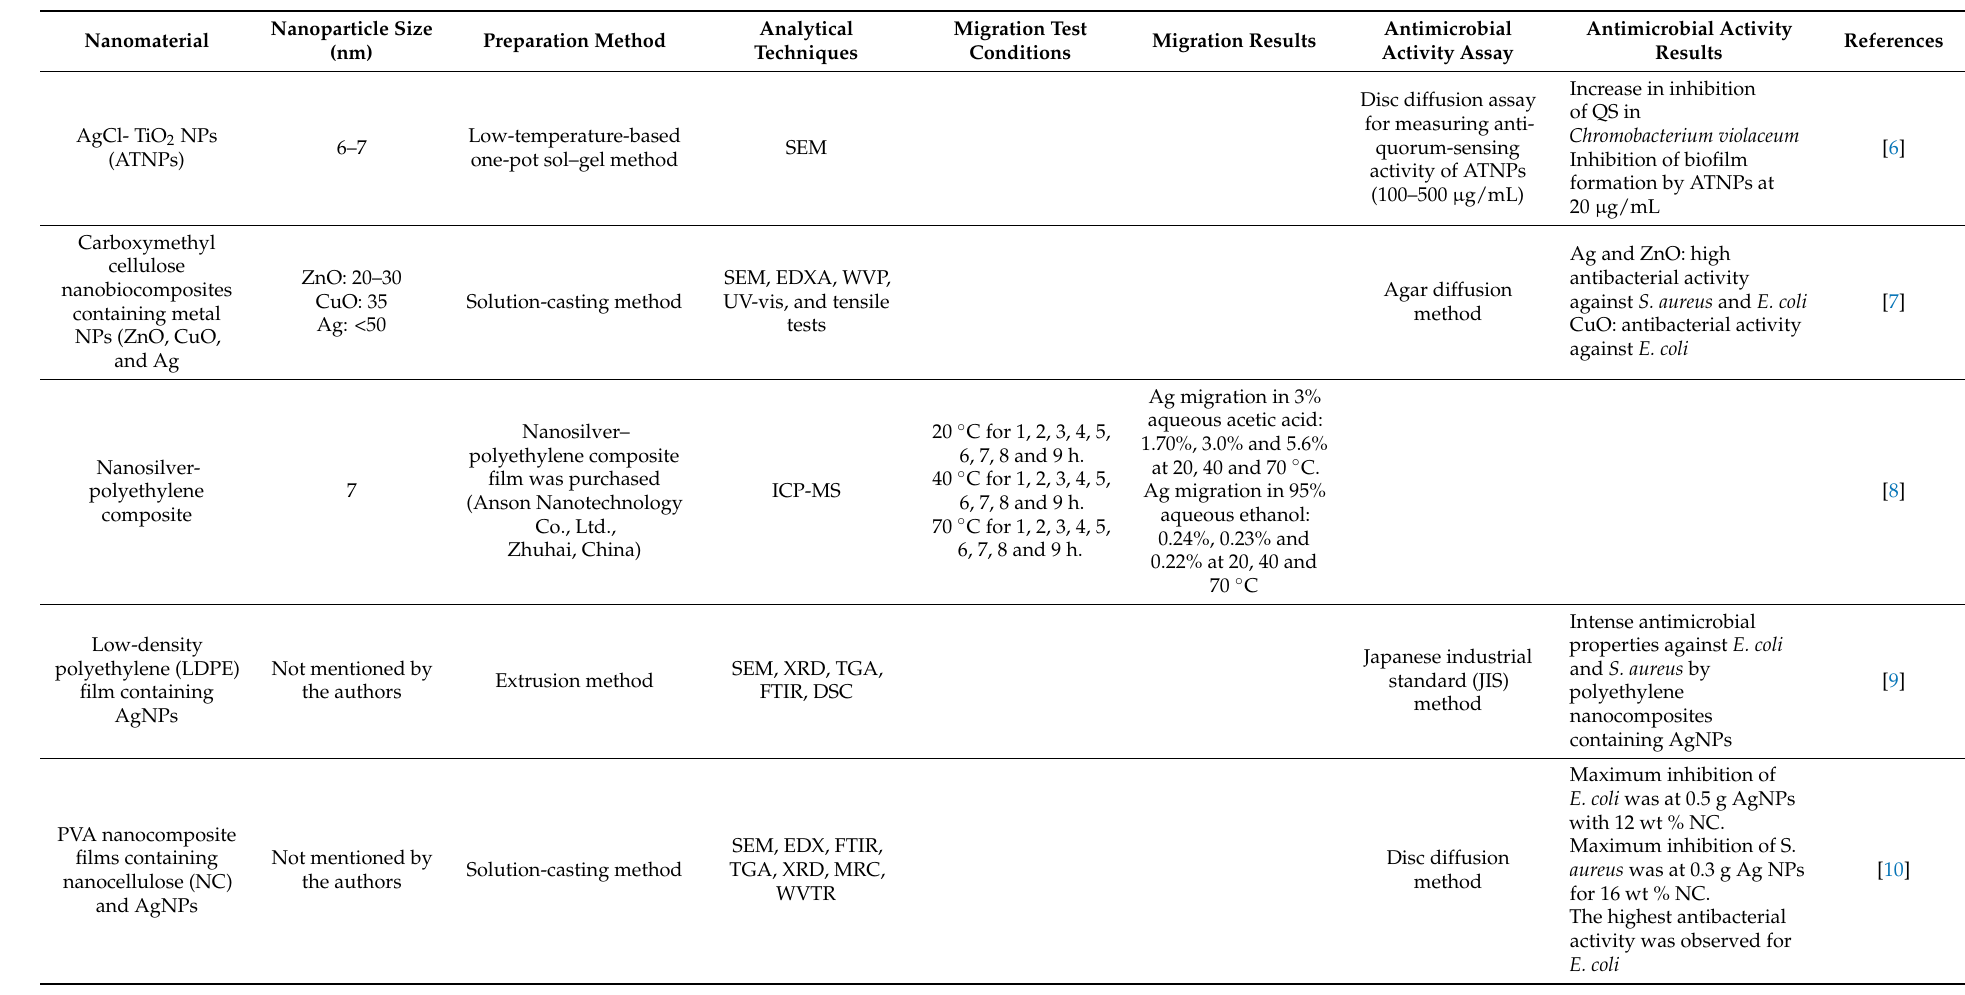
Table 2. Literature review of the application of nanosilver, nanocopper, and nanoclay particles in food packaging, focusing on their migration and antimicrobial properties.